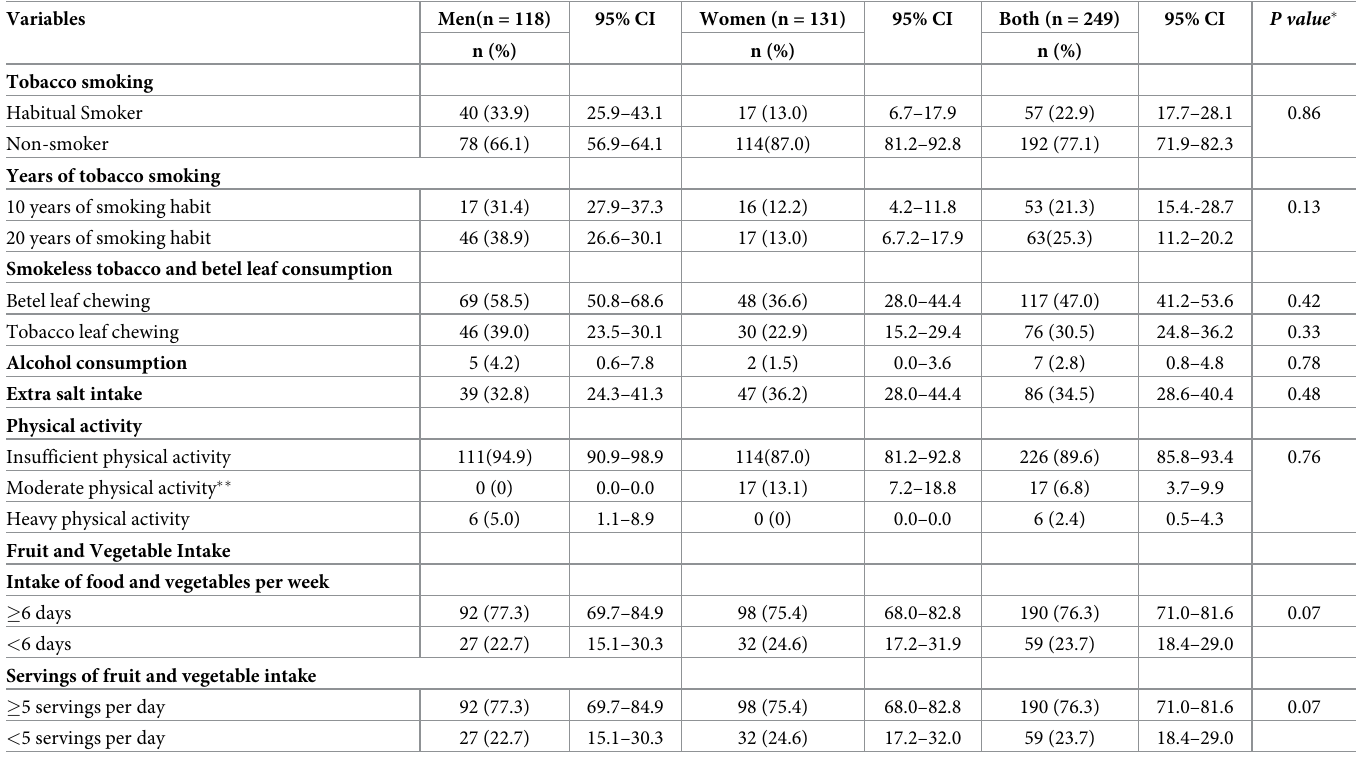
Table 2. Behavioral risk factors of NCD among the